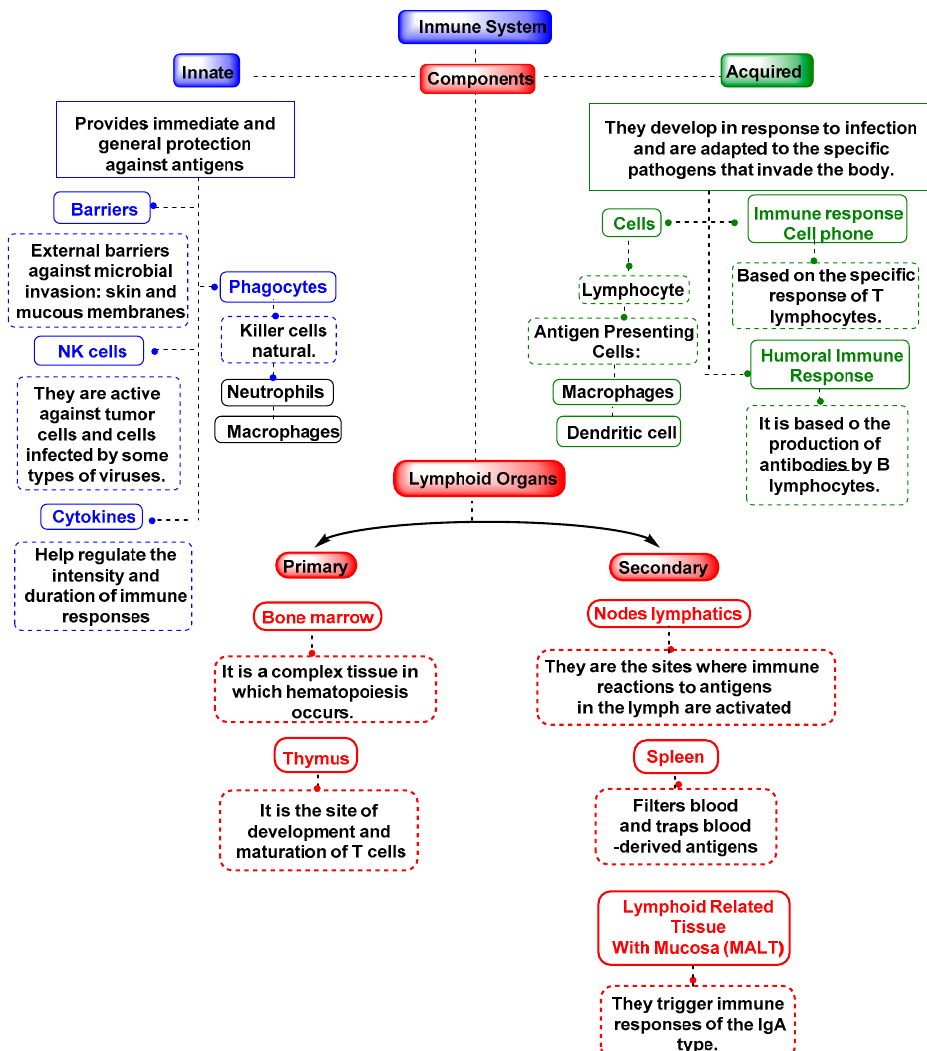
Figure 4. Mechanisms of the immune system, both innate and adaptive.